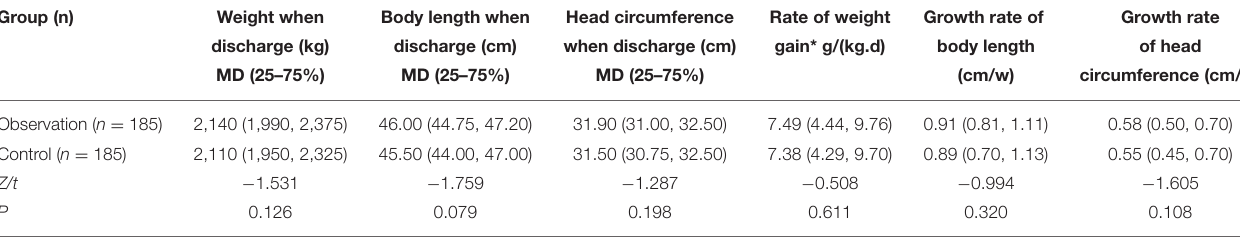
TABLE 8 | Comparison of growth and development indexes at discharge and growth rate during hospitalization. Group (n)